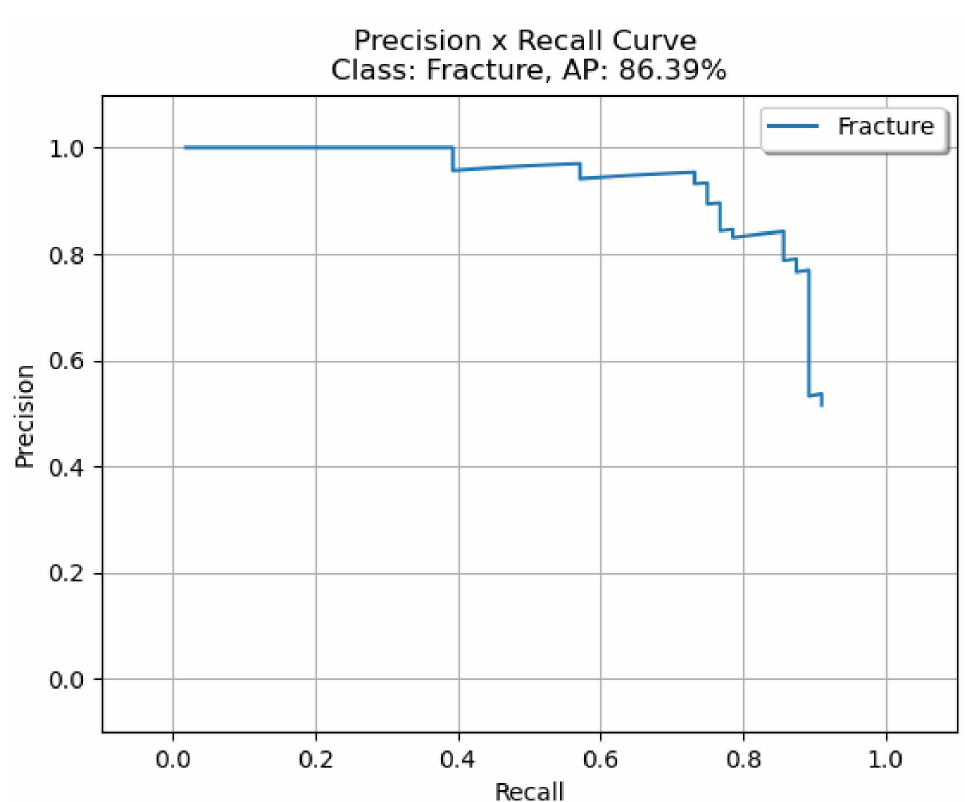
Figure 22. Count of predicted bounding box.